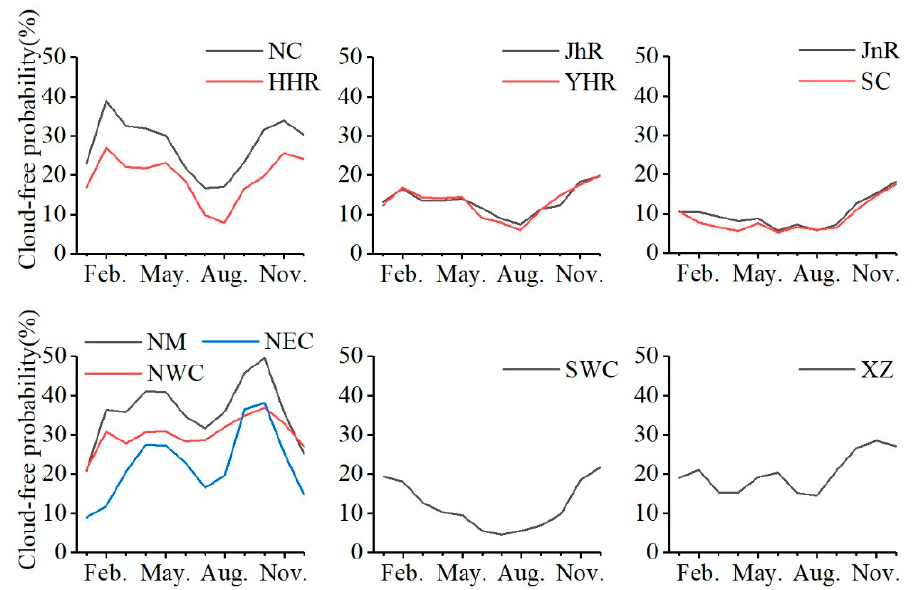
Figure 3. The monthly variations in the probability of acquiring cloud-free imagery throughout the regions.